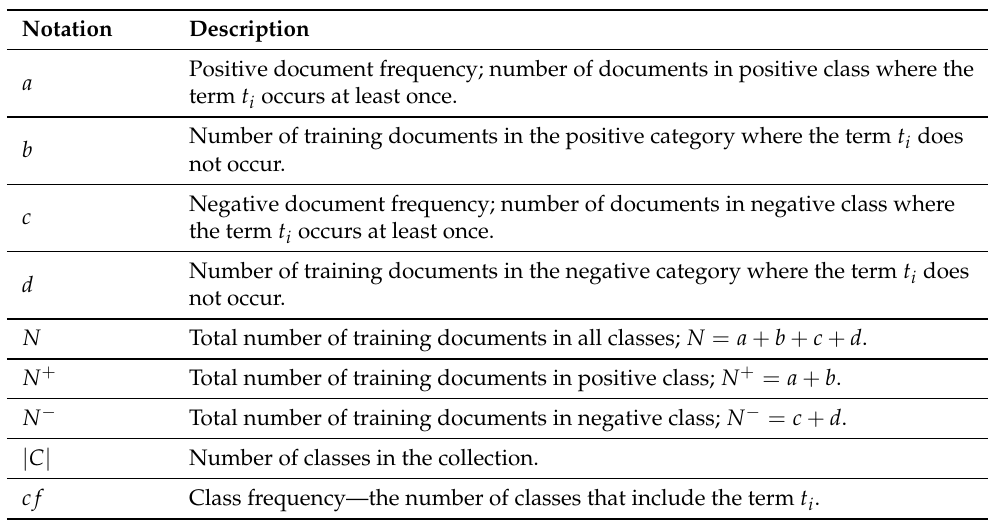
Table 2. Notations to formulate global